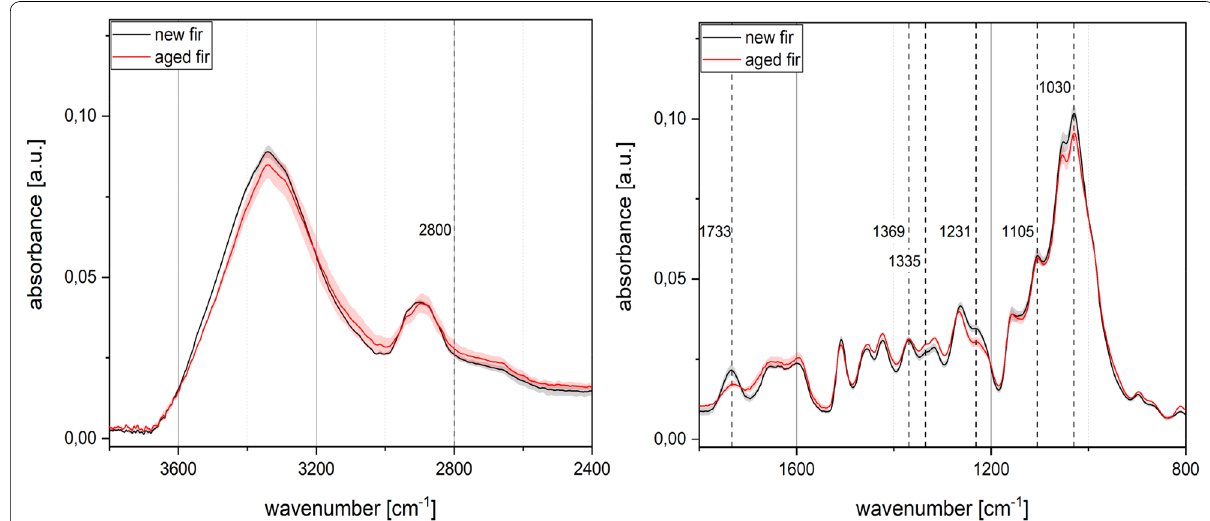
Fig. 2 FTIR spectra of new and aged fir wood samples. The semi-transparent area around the data plot indicates the standard deviation of the two averaged